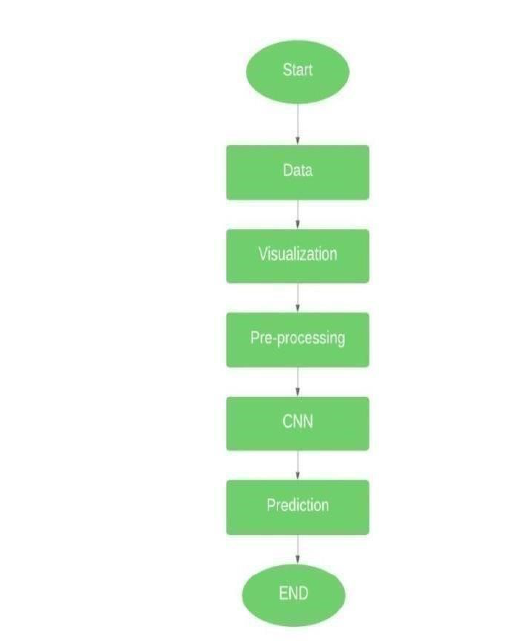
Figure 3.3: Flowchart for Proposed